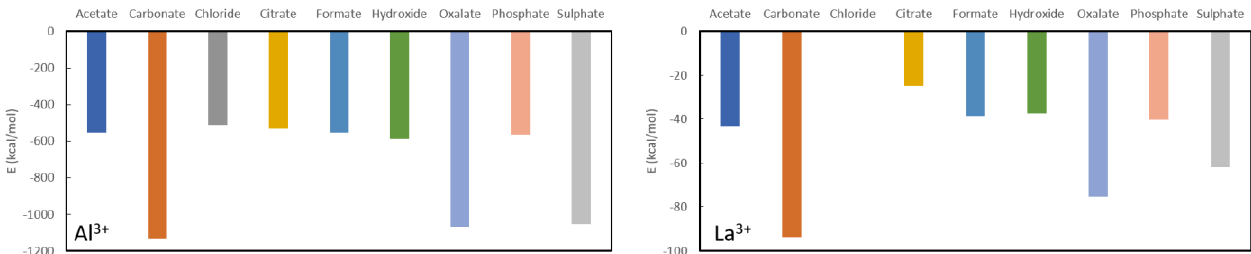
Figure 3. Formation energies for the complexes with Al 3+ ( left ) and La 3+ ( right